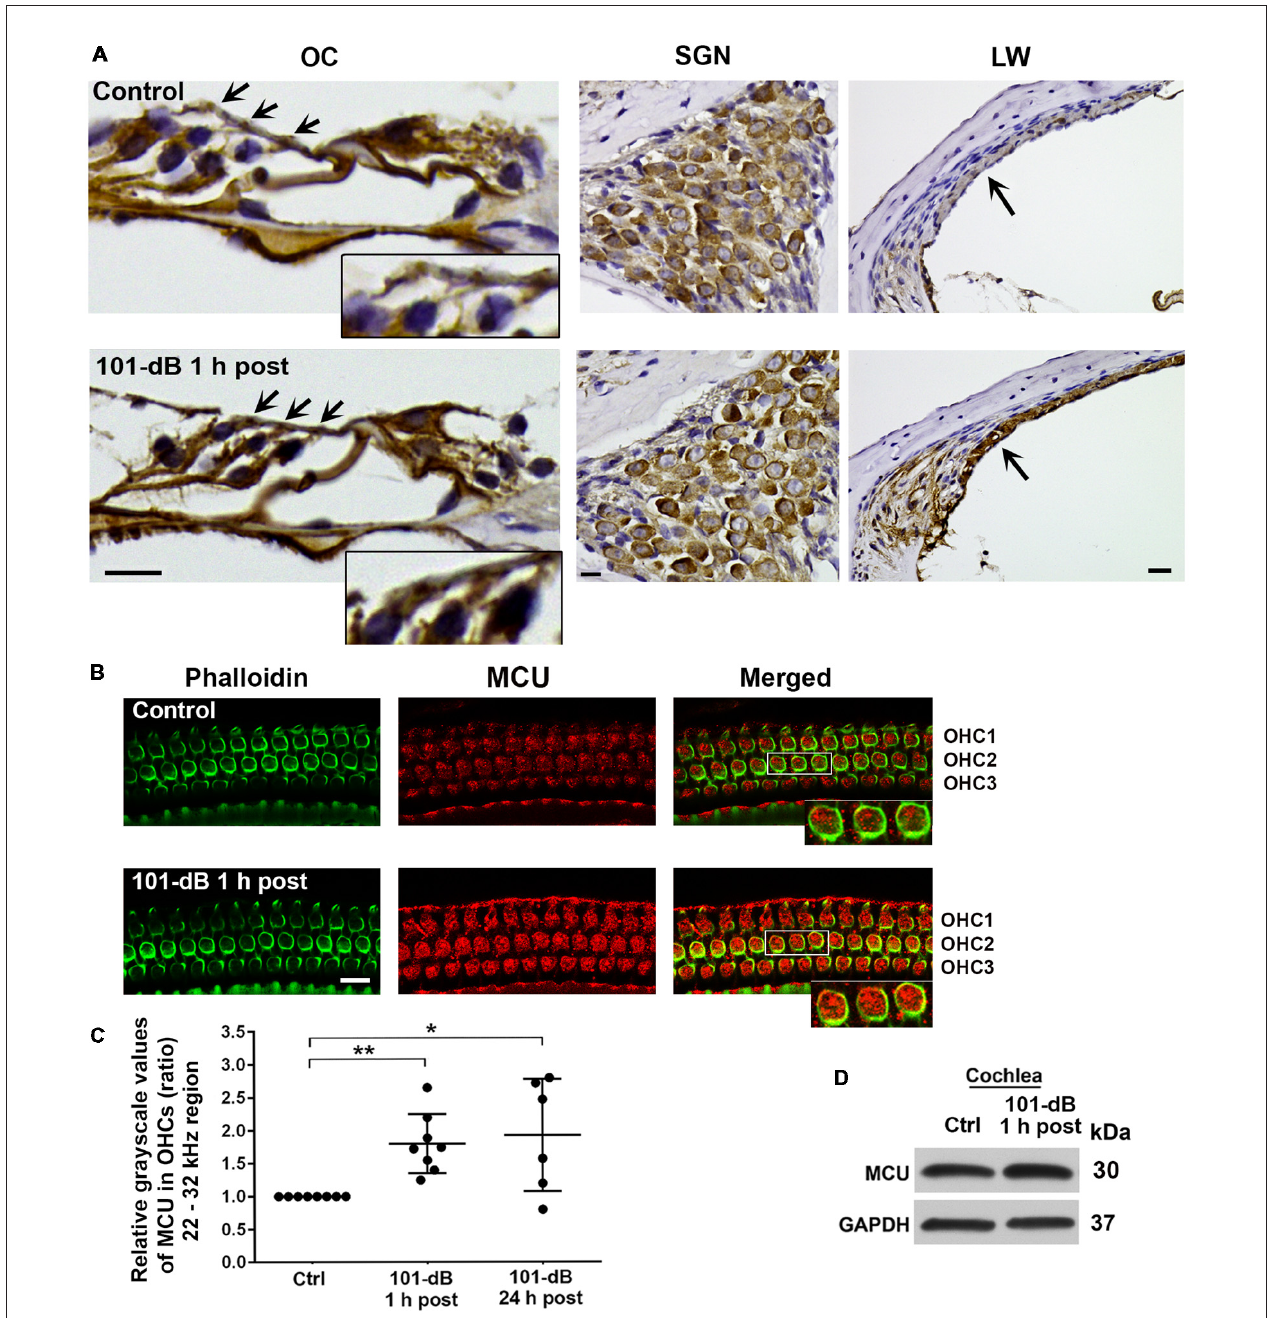
FIGURE 3 | Noise exposure increased immunolabeling for MCU in OHCs and the stria vascularis of the basal turn. (A) Paraffin sections of the adult CBA/J mouse inner ear revealed an increase in immunolabeling for MCU in DAB-stained OHCs (arrows and enlarged image inserts) in the organ of Corti (OC) and the stria vascularis (arrow) in the lateral wall, and no obvious change in spiral ganglion neurons (SGNs) examined 1 h after completion of the 101-dB noise exposure. These images were taken with 40 × -magnification lens and are representative of five individual mice per group; scale bar = 10 µ m. (B) Representative images for MCU in OHCs of surface preparations stained with phalloidin when processed 1 h after completion of the noise exposure. An enlarged image of three OHCs better illustrates the immunolabeling for MCU. Images were taken from the area of the basal turn corresponding to 22–32 kHz; OHC1, 2, 3 indicate the three rows of OHCs, scale bar = 10 µ m. (C) Quantification of immunolabeling for MCU in OHCs in the 22–32 kHz region showed a significant increase when processed 1 h after and 24 h after completion of the exposure. Data are presented as individual points and means ± SD; ∗ p < 0.05, ∗∗ p < 0.001. Control: n = 8, 101-dB 1 h post: n = 8, 101-dB 24 h post: n = 6 with one cochlea from each mouse in the group. (D) Immunoblots using total cochlear homogenates of CBA/J mice revealed no difference in MCU band densities between control (Ctrl) and noise-exposed mice processed 1 h after completion of the noise exposure (101-dB 1 h post). GAPDH was used as a loading control; n = 8 mice per